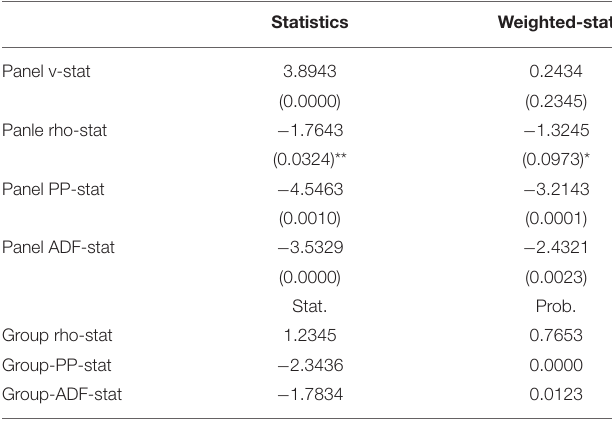
TABLE 6 | Co-integration